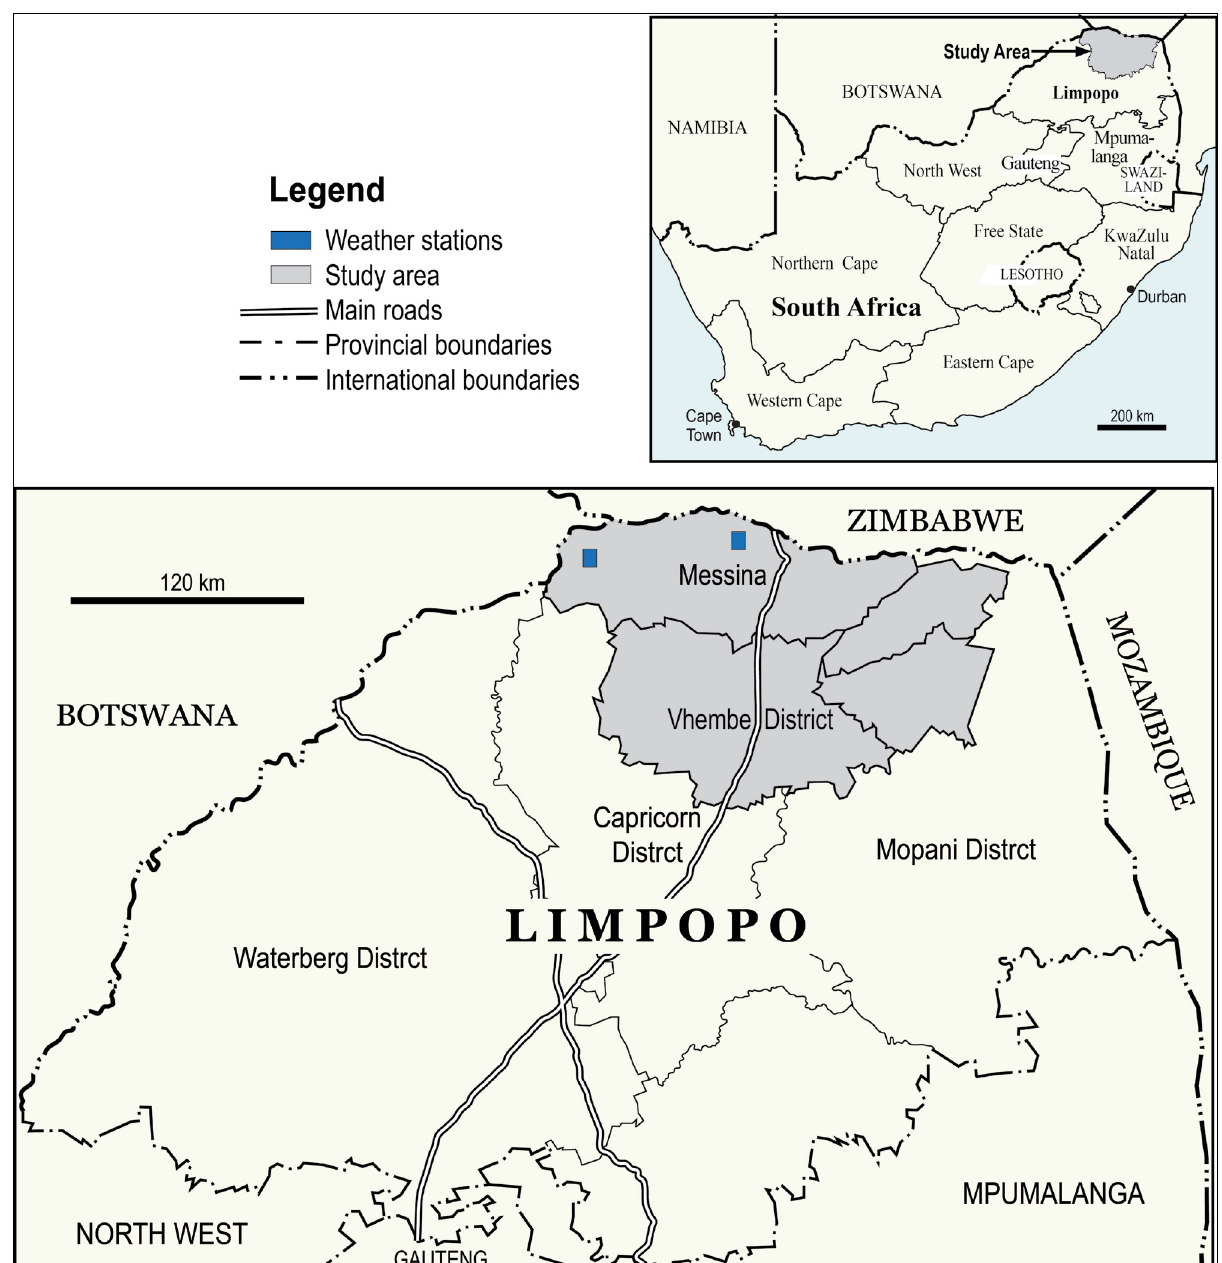
Figure 1: The study area: Northernmost Limpopo Province, South